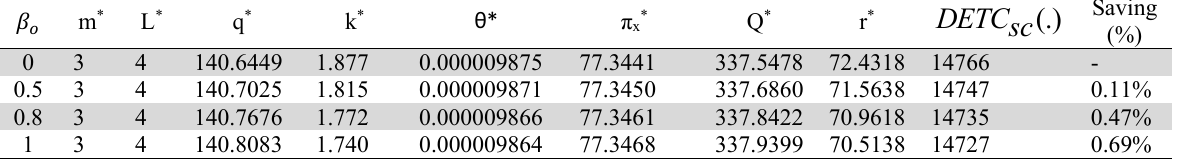
Summary of the optimal solution of numerical example (L * in weeks) (cid:2010)